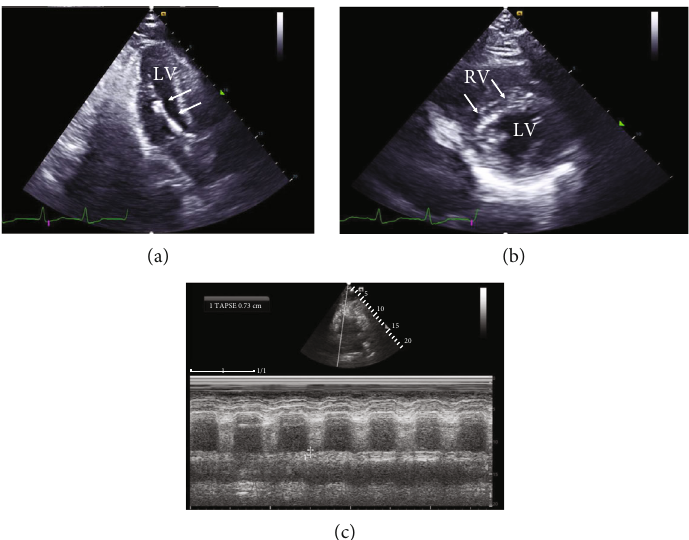
Figure 2: (a) Transthoracic echocardiogram (TTE) 3-chamber showing the Impella CP percutaneous left ventricular assist device (arrows) within the left ventricle (LV). (b) TTE short axis view demonstrating septal fl attening (arrows) indicating right ventricular (RV) pressure/ volume overload; the RV is dilated as well. (c) TTE M-mode of the tricuspid annulus showing decreased (dashed line) tricuspid annular plane systolic excursion (TAPSE) of 0.73cm suggesting RV dysfunction.